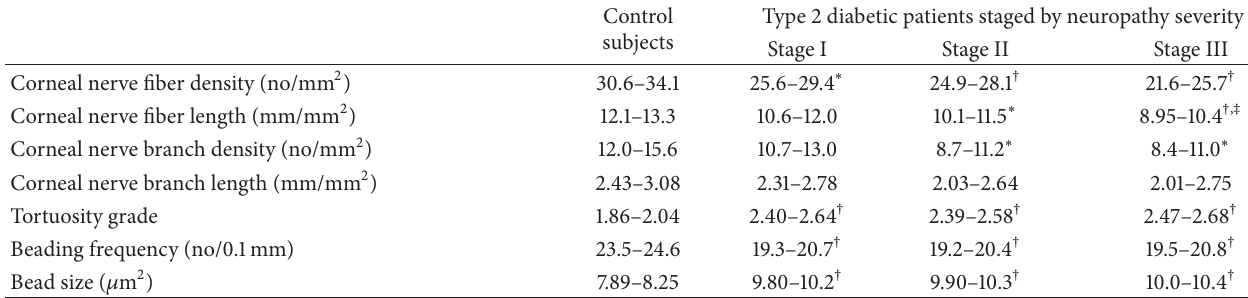
Table 3: Corneal nerve fiber measures in control subjects and subgroups of type 2 diabetic patients stratified by the severity of neuropathy.